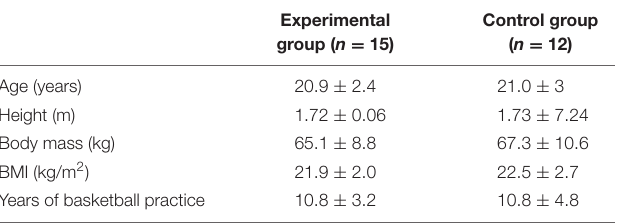
TABLE 1 | Initial characteristics of experimental and control